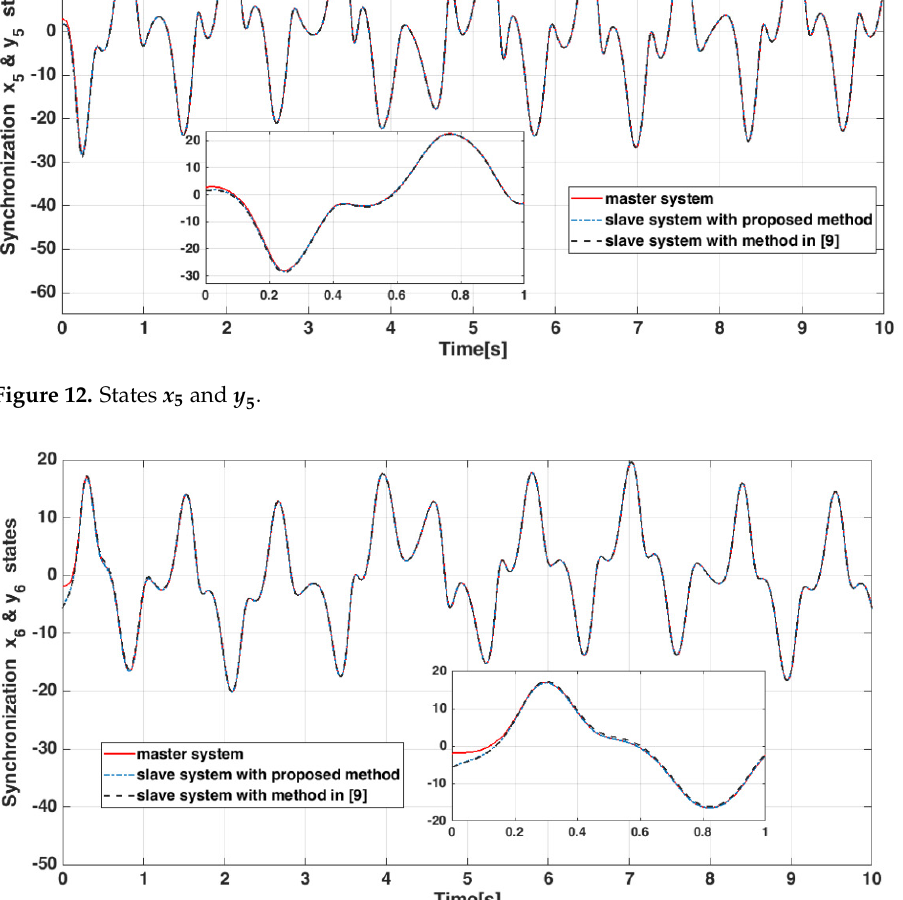
Figure 13. States x 6 and y Figure 13. States 𝒙 𝟔 and 𝒚 𝟔 6